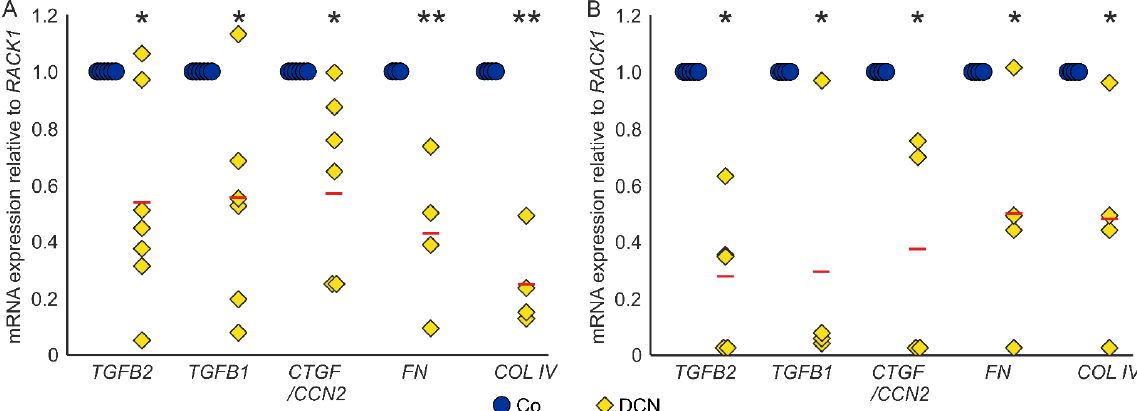
Figure 4. DCN reduces expression of TGF-βs and response genes in murine ON astrocytes ( A ) and human ONH astrocytes ( B ). ( A ) Expression levels of TGF-βs, CTGF/CCN2, FN and COL IV were reduced in murine ON astrocytes after treatment with 25 nM DCN. TGF-β2 : 0.54 ± 0.34, n = 7, p = 0.006, TGF-β1 : 0.56 ± 0.38, n = 6, p = 0.026, CTGF/CCN2: 0.59 ± 0.30, n = 7, p = 0.005, FN : 0.43 ± 0.21, n = 4, p = 0.005 and COL IV : 0.25 ± 0.13, n = 4, p = 0.0001. mRNA expression was normalized to RACK1 . Expression in untreated controls was set to 1. ( B ) Expression levels of TGF-βs , CTGF/CCN2, FN and COL IV were reduced in human ONH astrocytes after treatment with 25 nM DCN. TGF-β2: 0.27 ± 0.24, n = 5, p = 0.015; TGF-β1 : 0.29 ± 0.40, n = 4, p = 0.02; CTGF/CCN2 : 0.37 ± 0.36, n = 4, p = 0.011; FN : 0.49 ± 0.25, n = 4, p = 0.049; COL IV : 0.47 ± 0.17, n = 4, p = 0.032. mRNA expression was normalized to RACK1 . Expression in untreated controls was set to 1. *, ** are significant with p ≤ 0.05 or p ≤ 0.01.